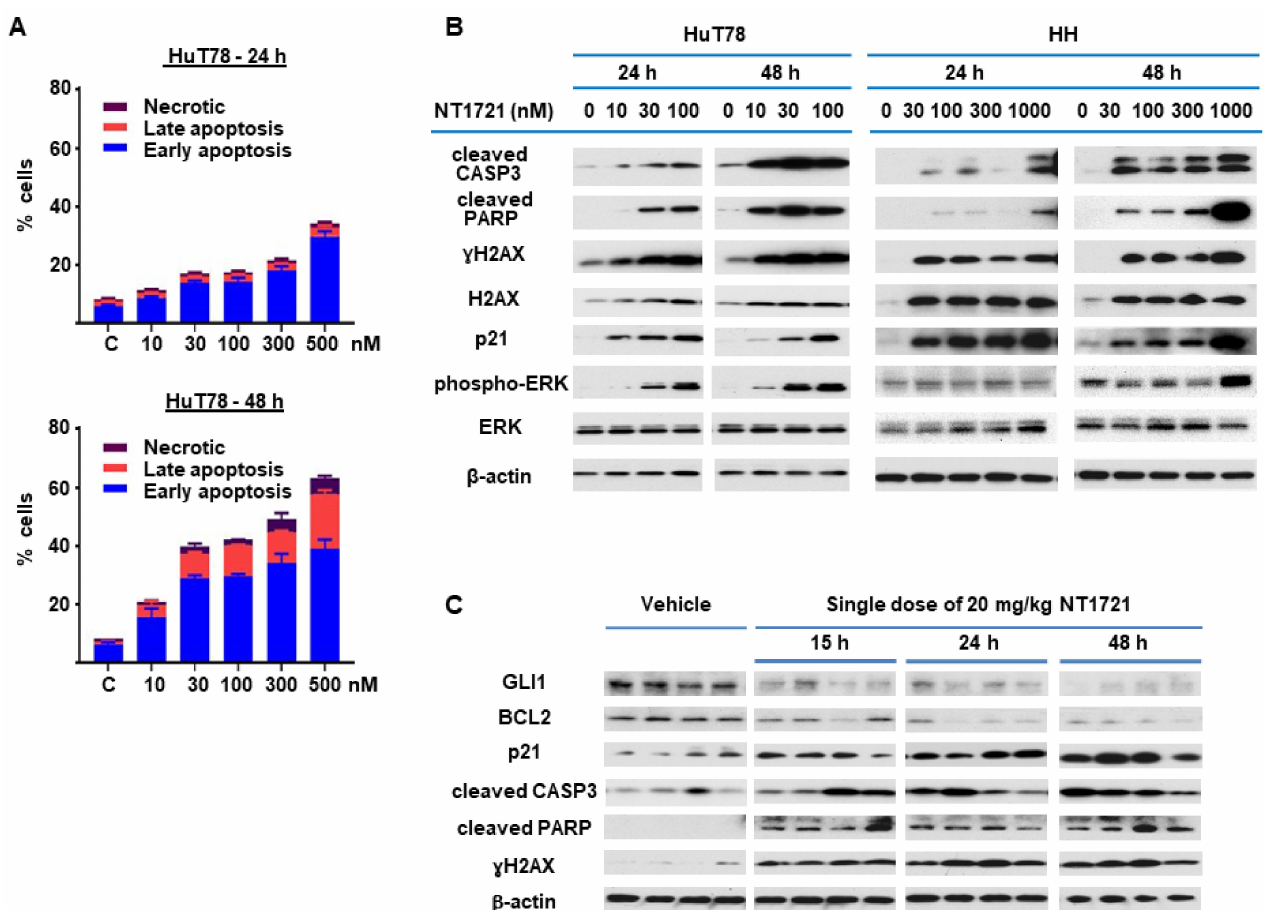
Figure 3. NT1721 induced apoptosis in CTCL cells in vitro and in vivo. ( A ) HuT78 cells were treated with NT1721 for 24 h or 48 h, then stained with annexin V and subjected to FACS analysis. ( B ) HuT78 and HH cells were treated with NT1721 as indicated. Western blots were used to analyze the expression of genes related to apoptosis induction. ( C ) Apoptosis induction in vivo. NSG mice harboring HuT78 tumors ( n = 4 per group) were treated by gavage with a single dose of NT1721 (20 mg/kg) or the vehicle (3.3% DMSO/30% solutol in PBS). The tumors were then harvested at the indicated time points and subjected to Western blot analysis. Original Western Blots of Figure 3B,C available in Figure